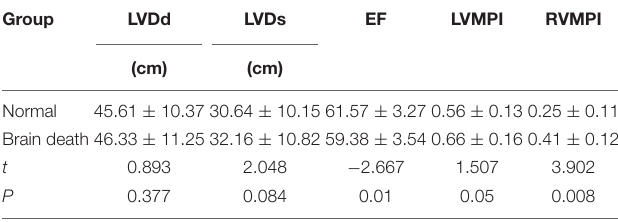
TABLE 2 | Parameters of echocardiography in brain death group and normal